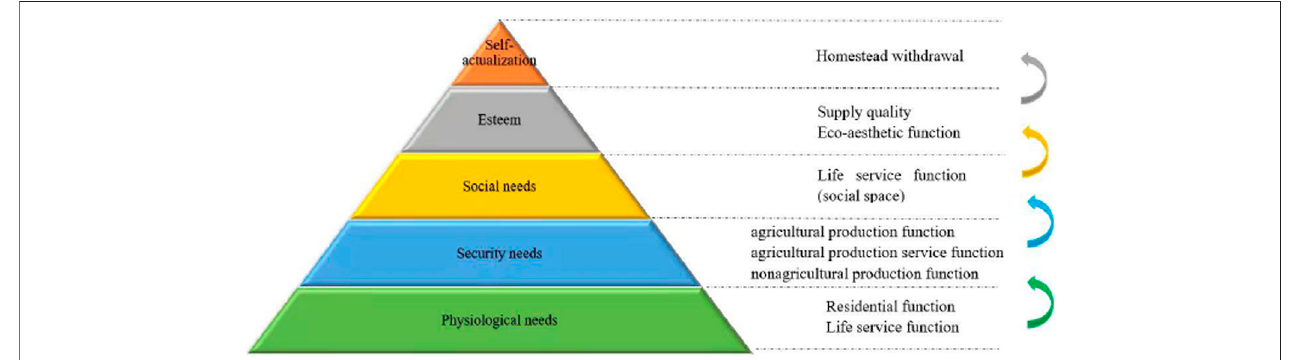
FIGURE 1 | Maslow ’ s hierarchy of needs applied to farmers in rural homesteads.